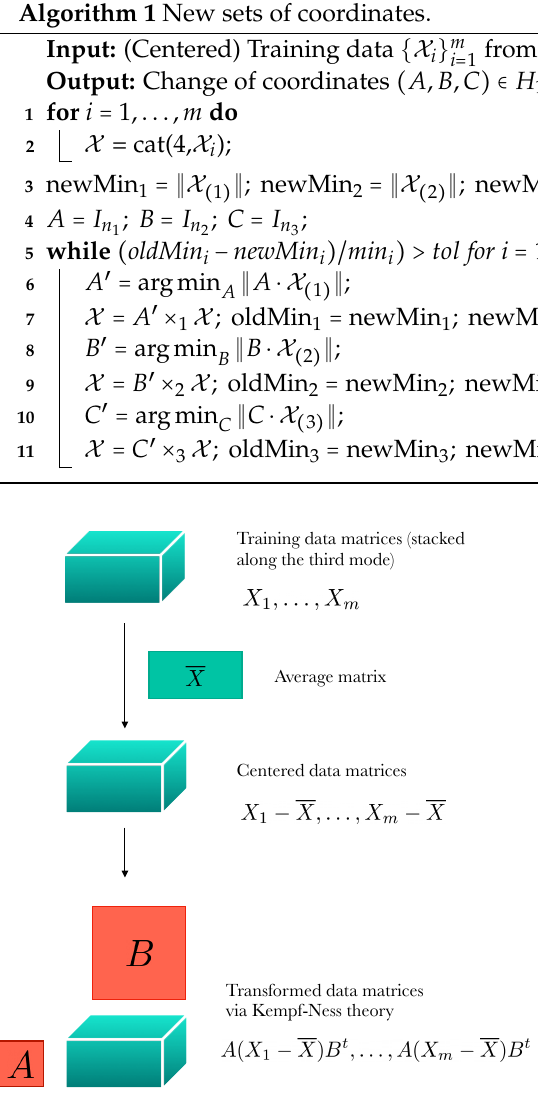
Figure 1. Graphical representation of Algorithm 1 in the case of matrix